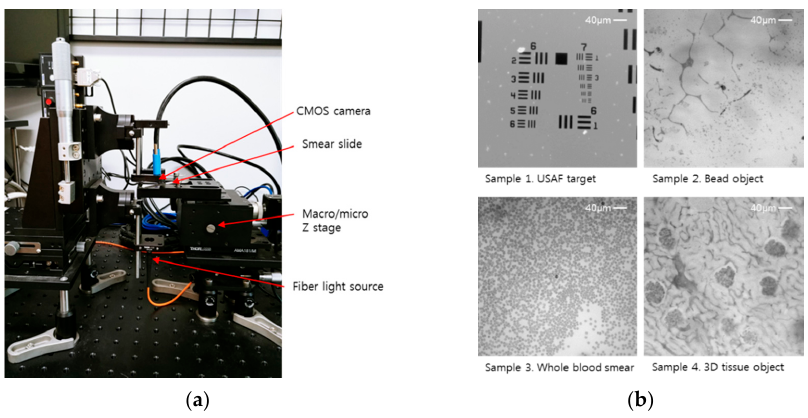
Figure 2. Image acquisition apparatus for the inline holographic microscopy and four different test samples. ( a ) From the fiber light source, a point, like a source, emits on the bottom of the sliding glass as a reference light. Between the slide and cover glass, a thin layer of the sample object scatters the reference light, which creates an interference pattern. The interference pattern, e.g., the hologram image, is propagated on a CMOS sensor surface. The CMOS camera (10.7 Mp, 1.67 µ m pixel size) is placed